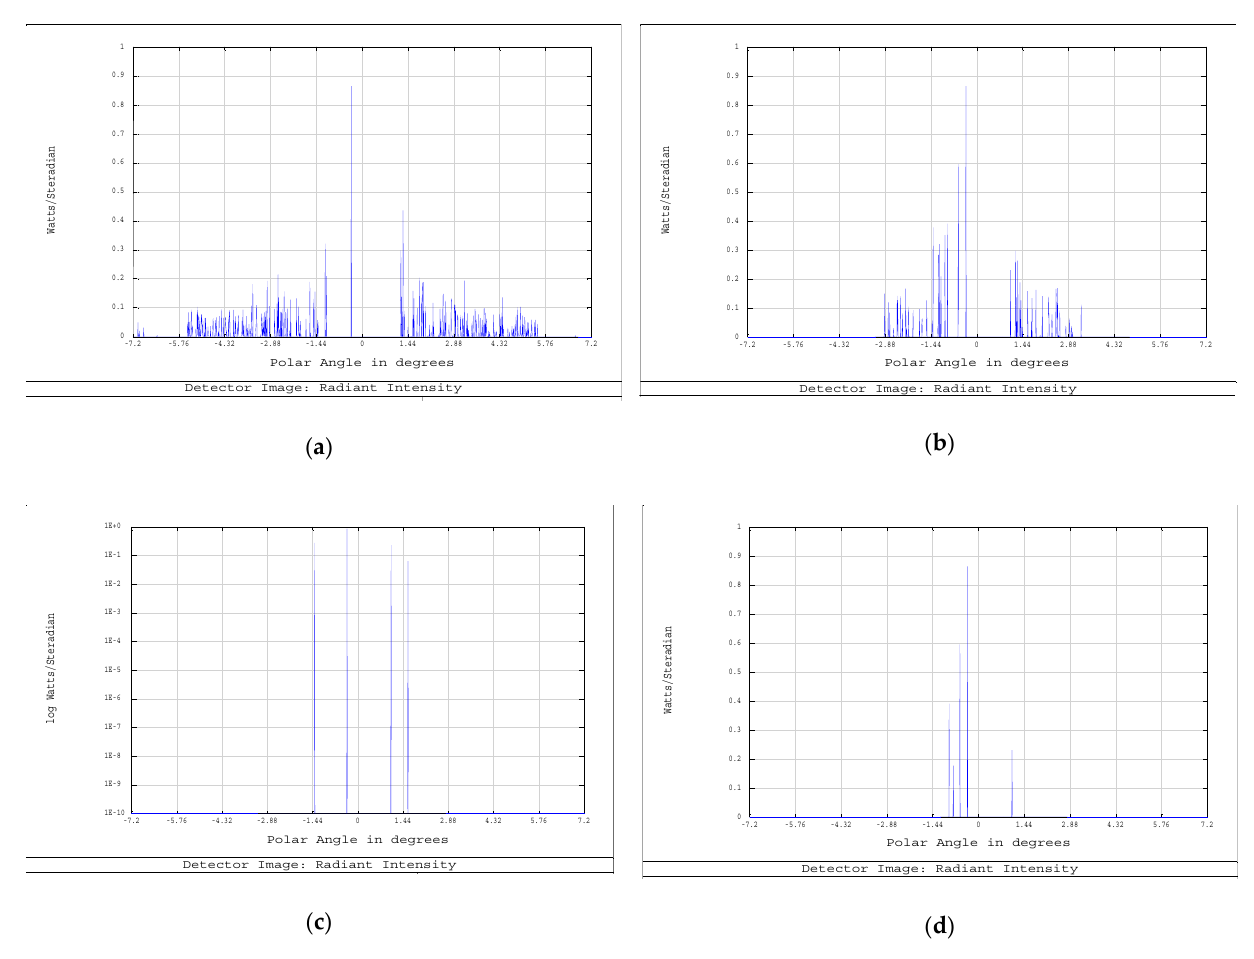
Figure 8. First-order stray light analysis: angular cross sections on the detectors. ( a ) stray light at Detector #0 (after exit pupil, on primary mirror). ( b ) Detector #1 (on the image plane). ( c ) Detector #2 (between the two folding mirrors), ( d ) Detector #2.5 (before the spectrometer).